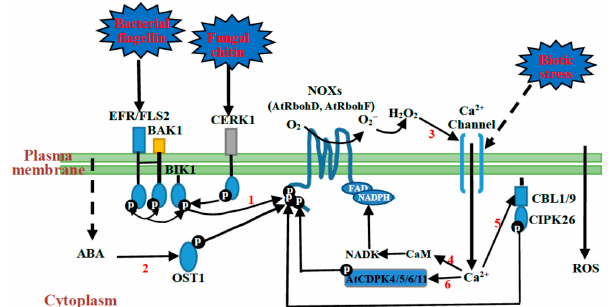
Figure 2. Phosphorylation-dependent regulation of NOXs during plant immunity. ( 1 ) Upon PAMPs perception, PRRs (pattern recognition receptors), such as chitin-elicitor receptor kinase 1 (CERK1), elongation factor-Tu receptor (EFR) and flagellin sensing 2 (FLS2), and co-receptor brassinosteroid insensitive 1 associated receptor kinase 1 (BAK1), directly phosphorylate and activate botrytis-induced kinase 1 (BIK1). Phosphorylated BIK1 has a higher binding affinity for AtRbohD and phosphorylates it on some specific sites; ( 2 ) In addition, the stress-mediated perception of ABA (abscisic acid) leads to activation of OST1 (open stomata 1), then it phosphorylates AtRbohF; ( 3 ) The produced H 2 O 2 itself may trigger further activation of Ca 2+ channel(s), forming a positive feedback regulation; ( 4 – 6 ) At the same time, a central second messenger Ca 2+ activates CDPKs (calcium-dependent protein kinases) and CBLs (Calcineurin B-like), then they phosphorylate AtRbohD and AtRbohF, respectively. CaM (calmodulin) is also activated by Ca 2+ , then CaM regulates NADK (NAD kinase) to produce NADPH. The solid lines and dashed lines represent determinate and potential interactions, respectively.